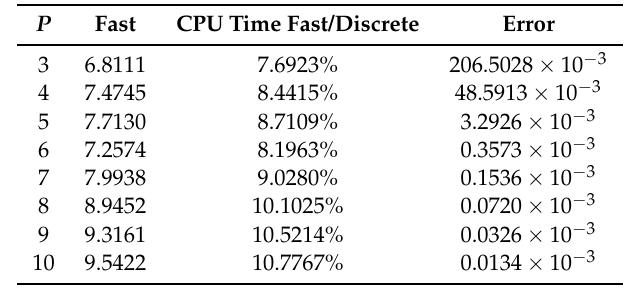
Table 4. Error and CPU time evolution for the SIW filter as the number of frequency points for the fast sweep ( P ) increases. Discrete sweep used 500 points and took 88.54 s.